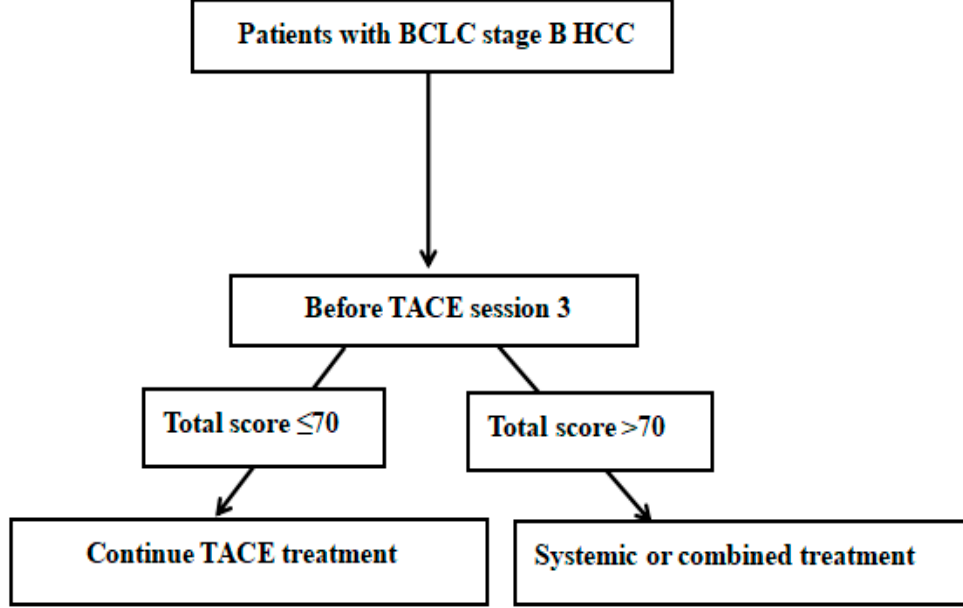
Figure 8. Proposal for nomogram ‐ II ‐ guided retreatment strategy with TACE. TACE: transarterial chemoembolization; BCLC: Barcelona Clinic Liver Cancer; HCC: hepatocellular chemoembolization; BCLC: Barcelona Clinic Liver Cancer; HCC: hepatocellular carcinoma.